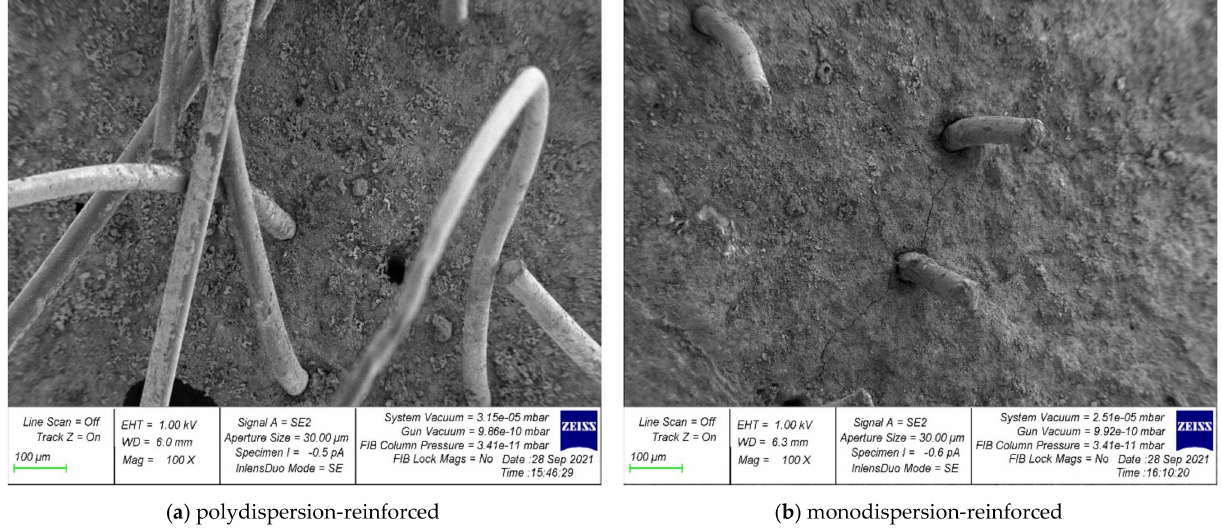
Figure 6. Microstructure of dispersion-reinforced fiber cement